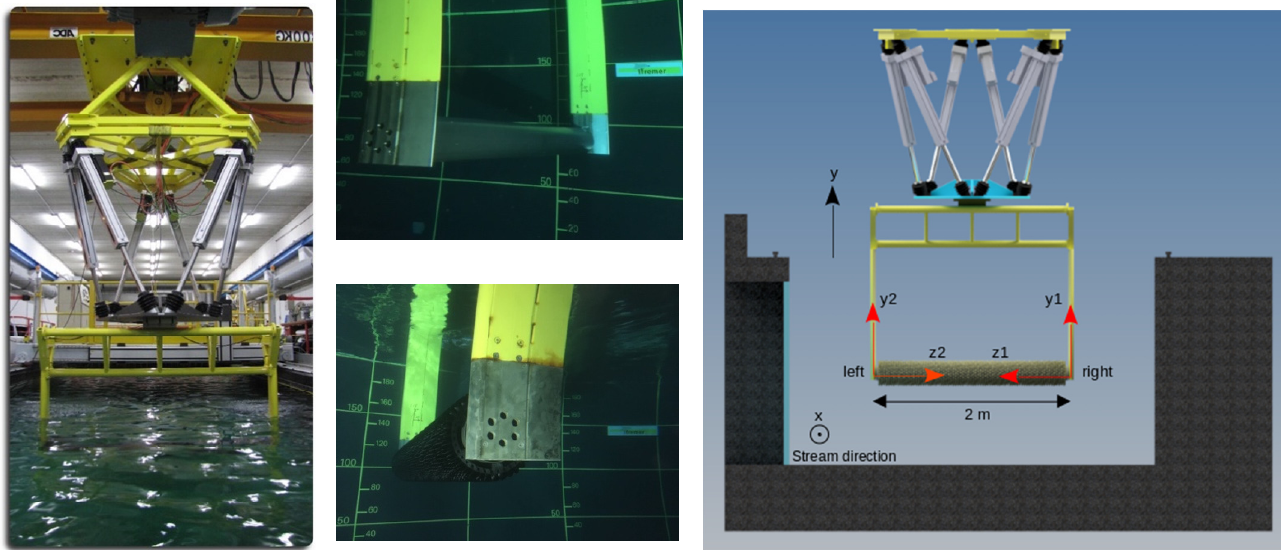
Figure 7. Presentation of the global set-up with the 6-axis hexapod ( left ), the smooth cylinder ( top center ) and one of the rough cylinder ( bottom center ) and axis coordinate system (x, y, z) used in tests ( left ). In black, the main system. The Ox axis is common to all systems and corresponds to the main flow direction. In red, the axes of the load cells ( right and left ).